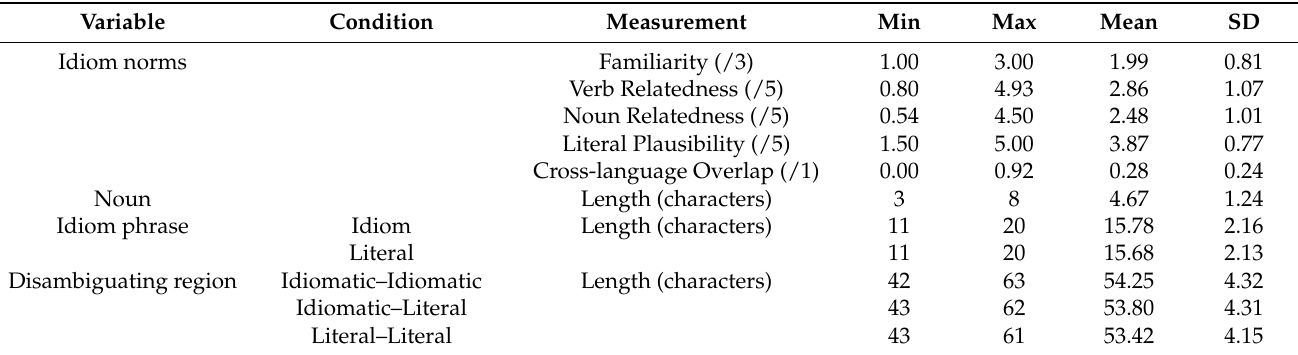
Table 3. Item and stimuli characteristics (Experiment